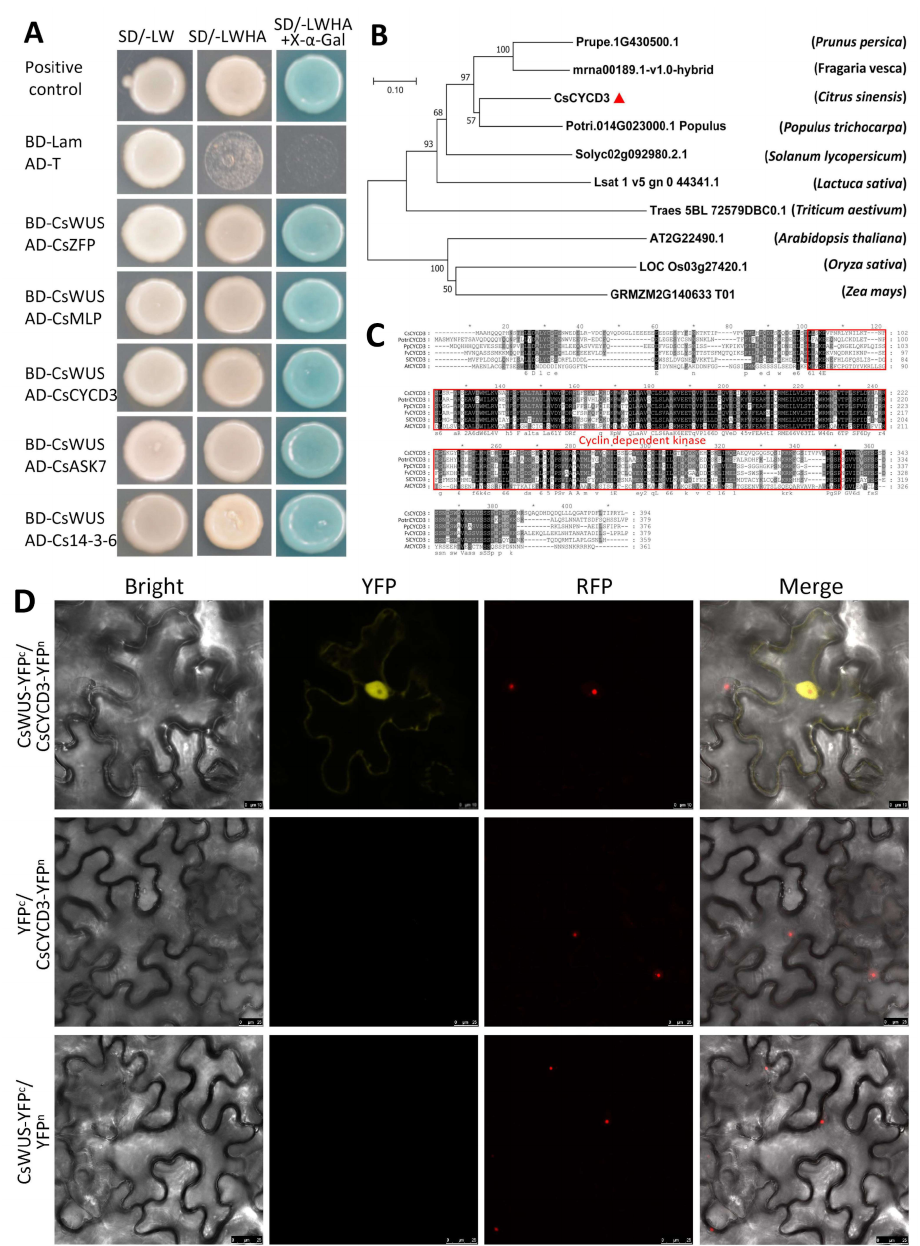
Figure 6. Protein interaction analysis of CsWUS protein. ( A ) Interacting identified proteins based on yeast two-hybrid screening. Yeast co-transformed with CsWUS as bait and AD-CsCYCD3, AD-Cs14-3-3, AD-CsASK7, AD-CsZFP, and AD-CsMLP as prey were dropped and deposited onto SD/-Trp-His-Ade-Leu or SD/-Trp-His-Ade-Leu medium with X- α -Gal. AD-T+BD-P53 was used as positive control and AD-T+BD-Lam as negative control. ( B ) Phylogenetic analysis of CsCYCD3 with homolog proteins. ( C ) Sequence analysis of CsCYCD3 protein with homolog proteins; CsCYCD3 from Citrus sinensis, AT2G22490.1 from Arabidopsis , Potri.014G023000.1 from Populus trichocarpa , mrna00189.1-v1.0-hybrid from Fragaria vesca , and Prupe.1G430500.1 from Prunus persica . ( D ) BiFC analysis in tobacco transient assays, where tobacco was co-transformed with YFPn and YFPc. Yellow fluorescent protein (YFP) images for the interaction of CsCYCD3-YFP N venus with CsWUS-YFP C were observed using YFP filter. The negative controls failed to yield detectable yellow fluorescence. RFP (Red mCherry) was used as a marker for nuclei. Scale bar = 20 µ